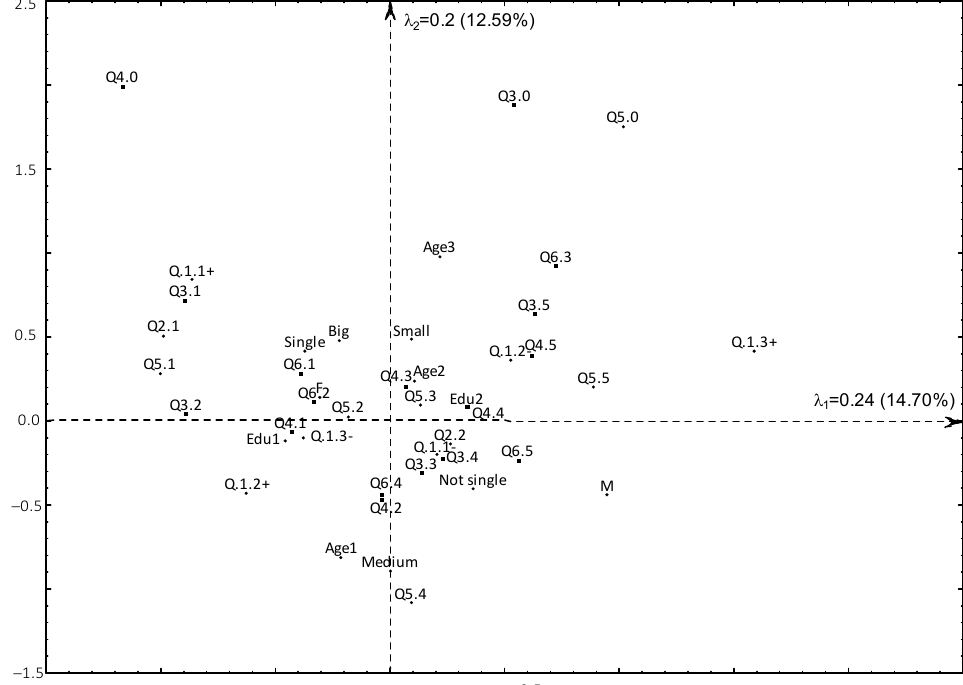
Table 3. Reasons for resigning from tourism (%).